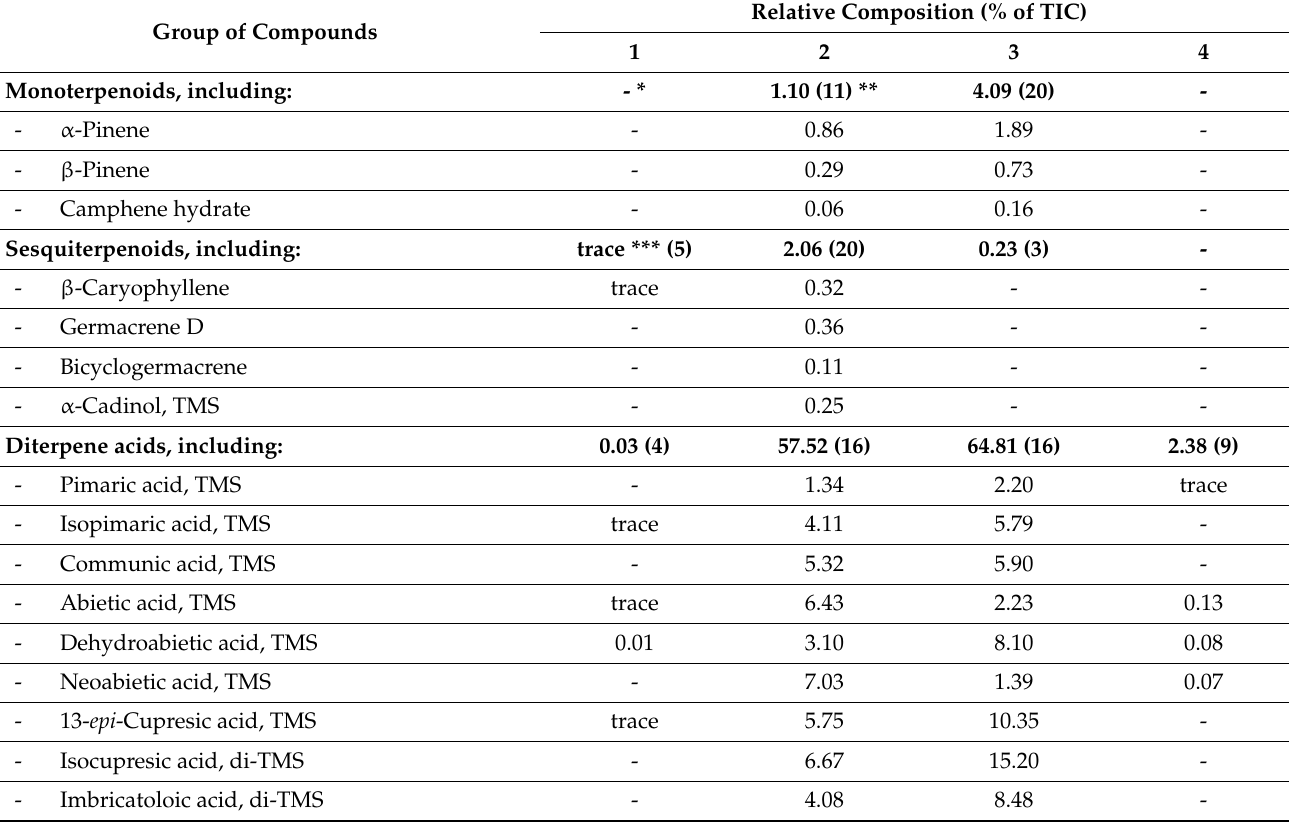
Table 3. Group composition of diethyl ether extracts of Argentine propolis of SLBs (1— S. postica